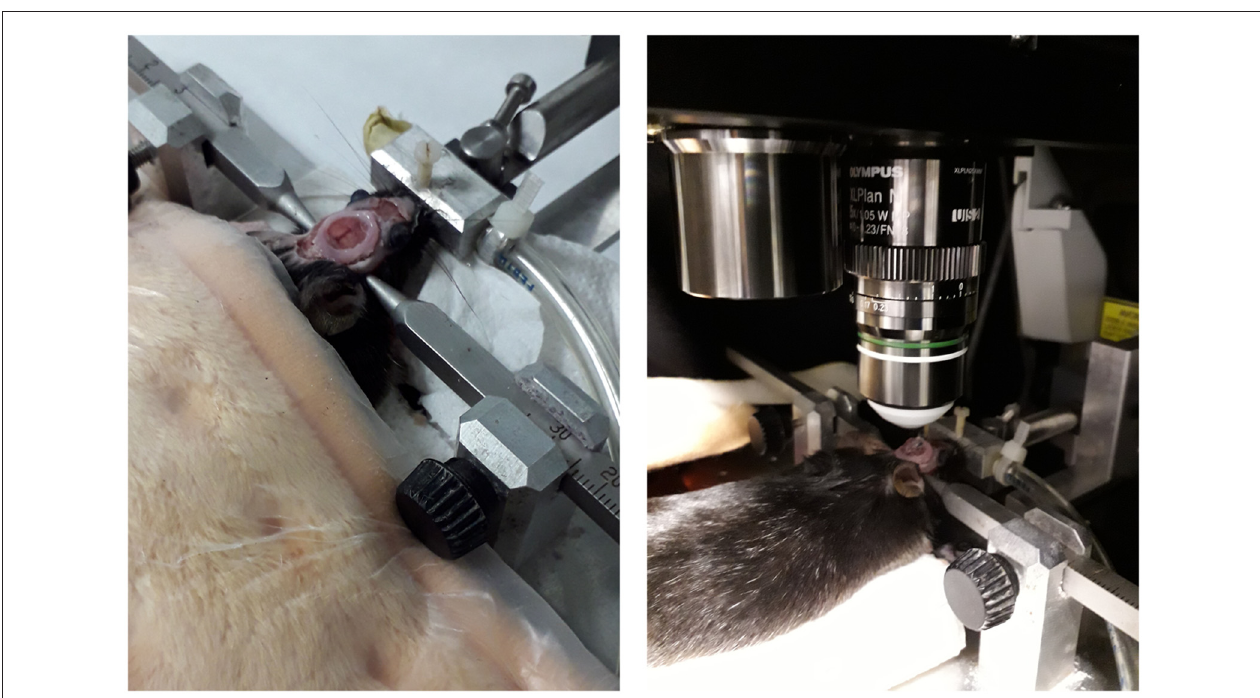
FIGURE 1 | Representative images of cranial window implantation and imaging setup for real time in vivo brain imaging with minimally invasive multiphoton microcopy